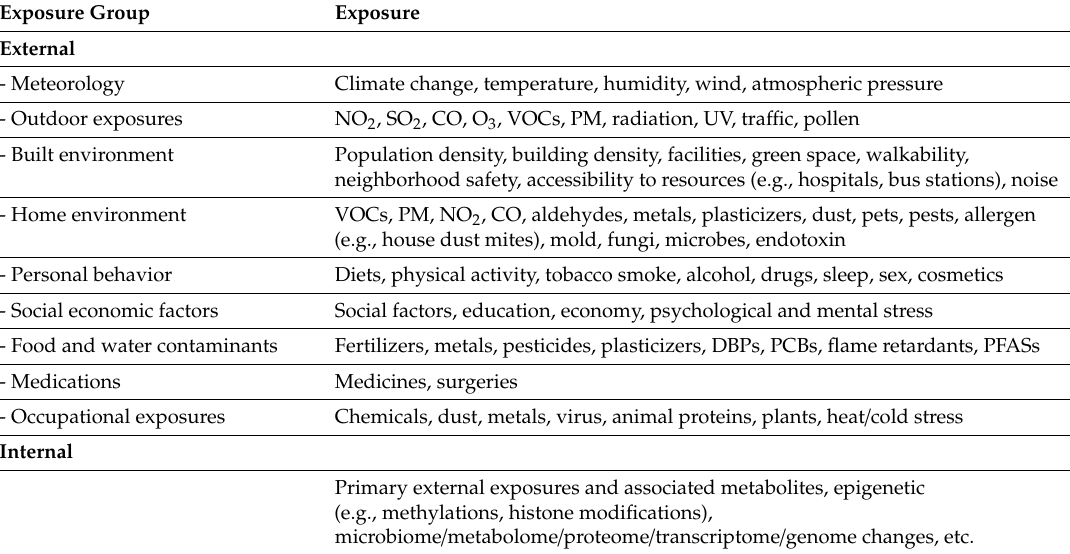
Table 1. Relevant exposures for inclusion in exposome